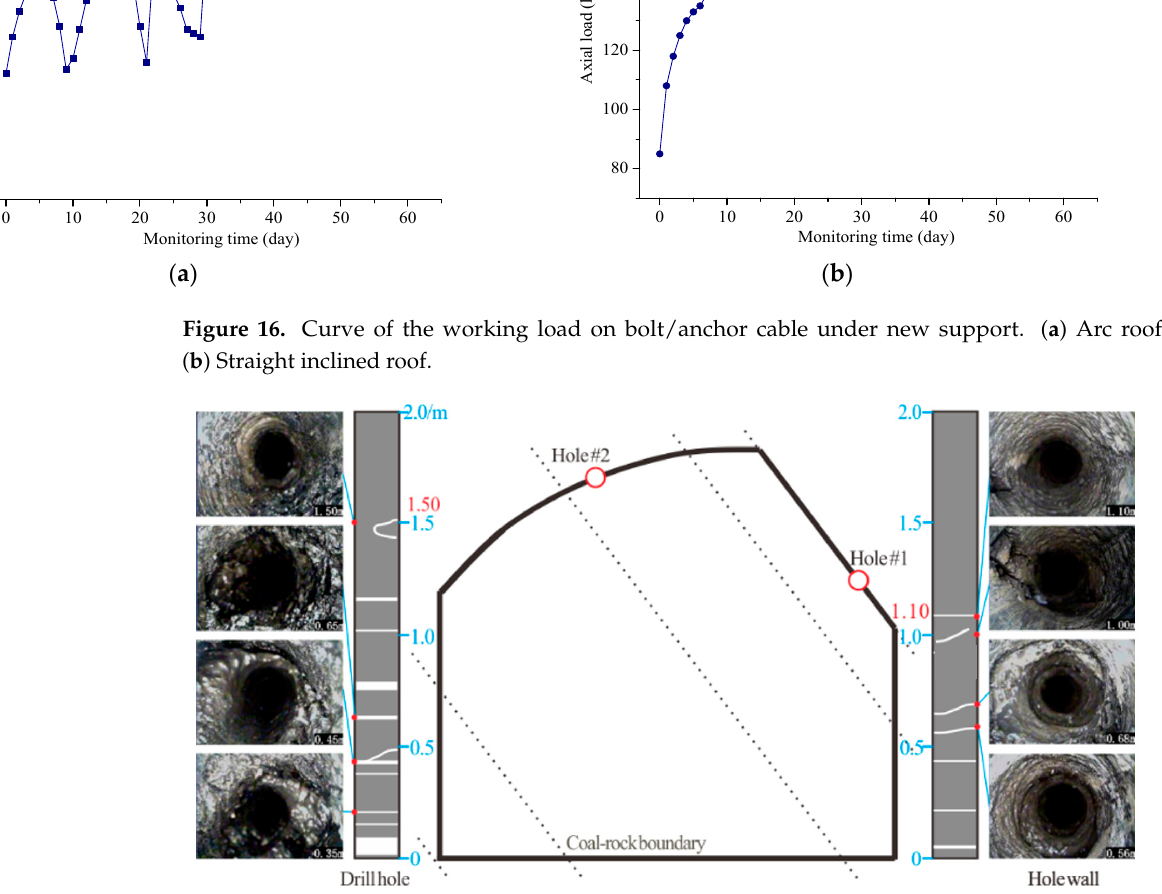
Figure 16. Curve of the working load on bolt/anchor cable under new support. ( a ) Arc roof; ( b ) Straight inclined roof.